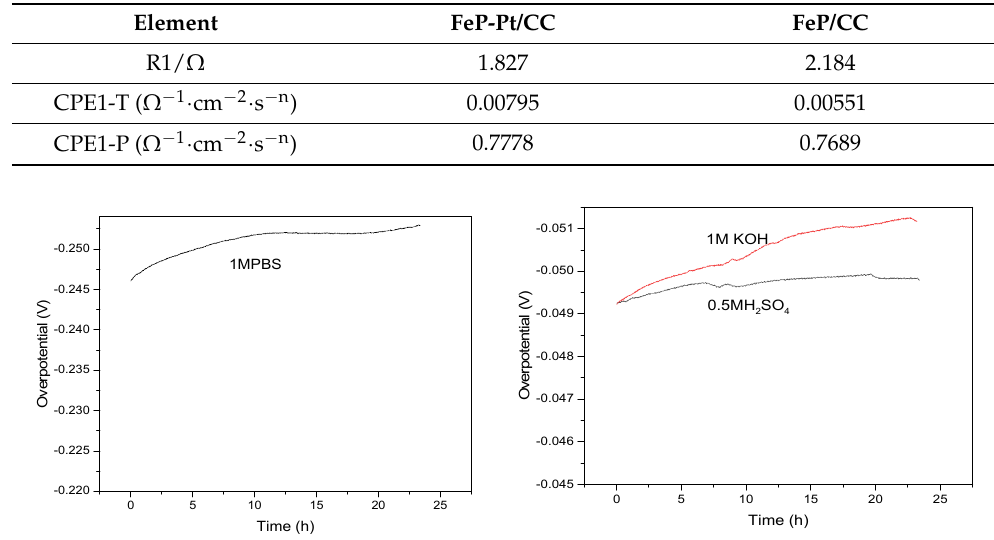
Figure 8. Time dependence of Overpotential for NiCo 2 P x at 10mA/cm 2 (in 0.5 M H 2 SO 4 , 1 M KOH and 1 M PBS).